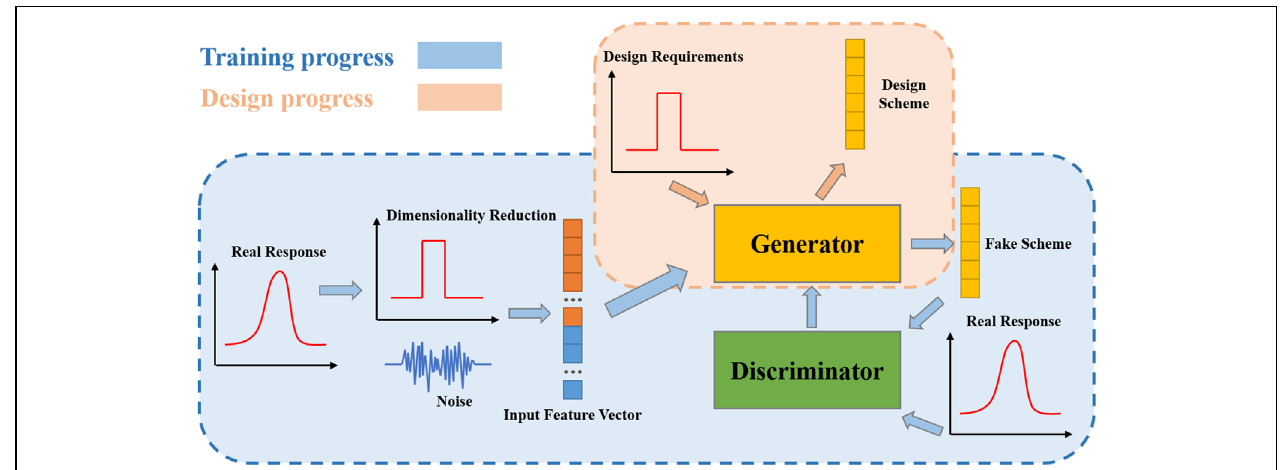
FIGURE 2 | Schematic representation of the design flow.